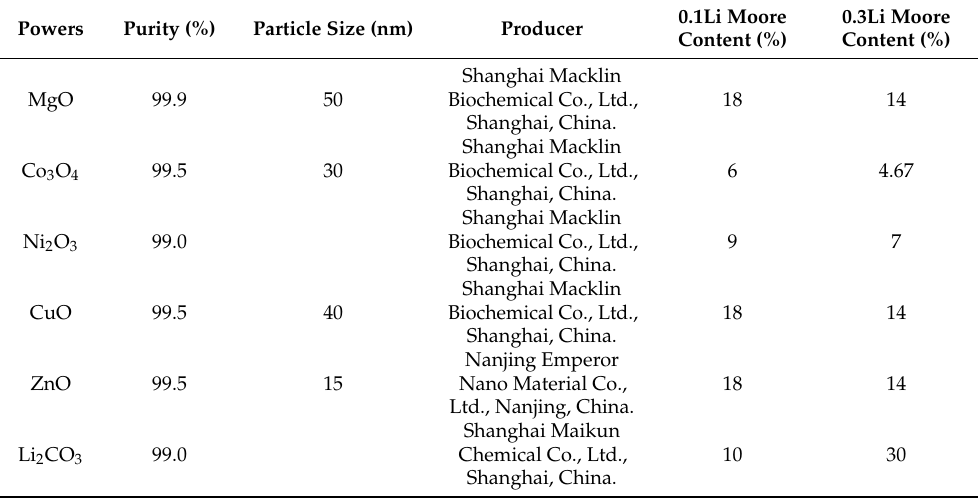
Table 1. Detailed information on the powders. (mol.% on the